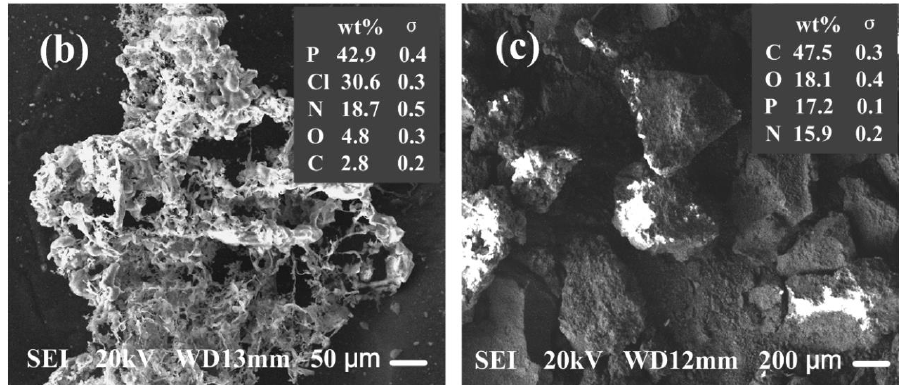
Figure 1. Synthesis route ( a ) and SEM ( b – c ) of HCCP and HCCP-SA; the inset shows the element content measurement result by EDS.